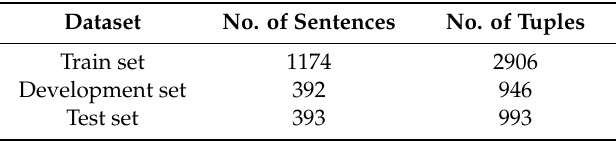
Table 3. WikiNews dataset overview.